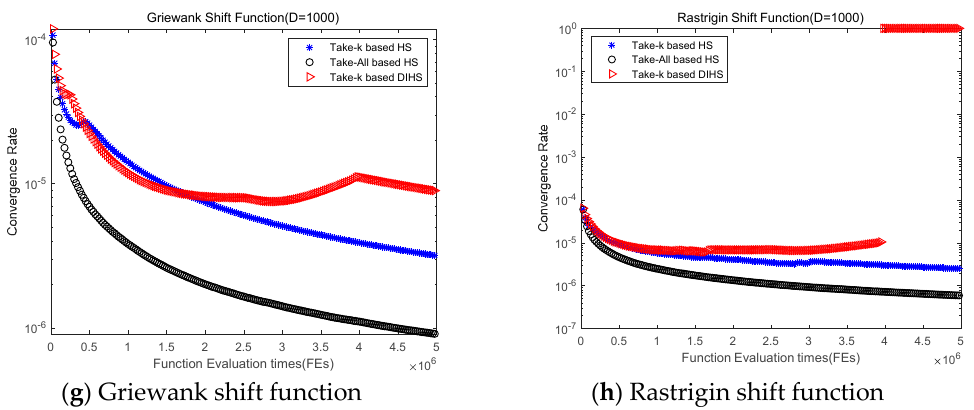
Figure 8. Convergence rates of 12 test functions by using three algorithms.